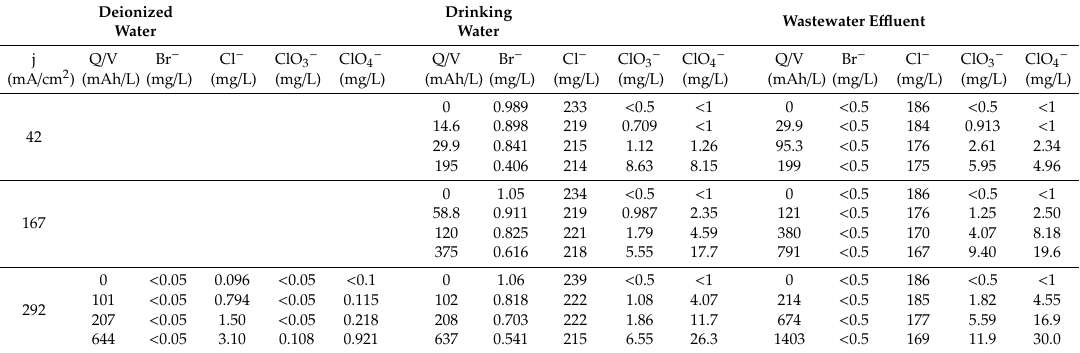
Table 2. Concentrations of chloride, bromide, chlorate and perchlorate, derived from IC analysis in deionized water, drinking water and wastewater e ffl